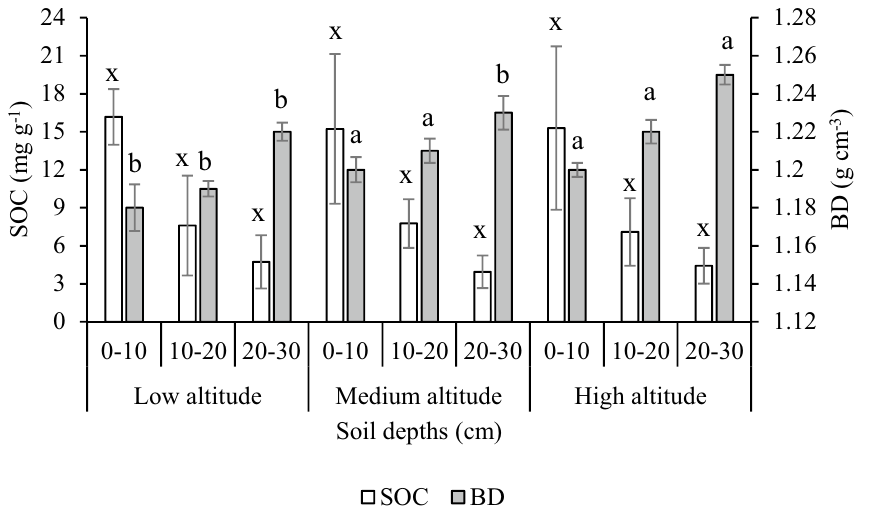
Figure 3. Soil organic carbon (SOC) concentrations and bulk density (BD) at 0–30 cm soil depth of homestead forests sampled across three altitudes. The secondary y-axis represents BD. Bars represent the standard error of the mean. Different alphabets (x, y, and z) and (a, b, and c) in the bars indicate the significant differences among different altitudes at the same soil depth for SOC and BD, respectively (p ≤ 0.05).